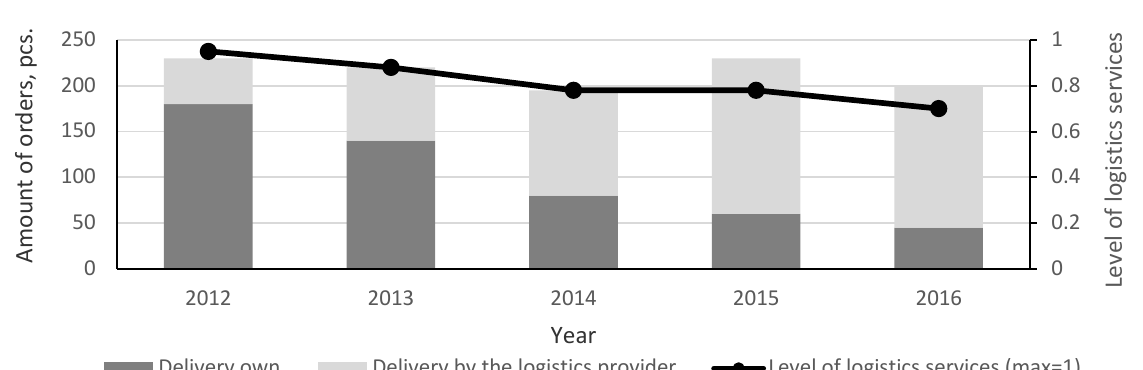
Figure 3. The volume of contracts of Sumy Engineering Works Ltd. in